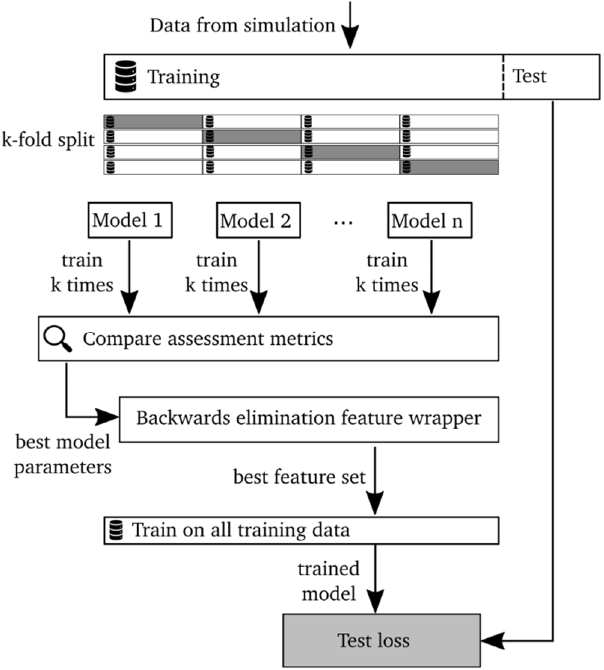
Figure 8. Workflow of the two-stage model selection process. At the first stage, the main neural network parameters are determined and at the second stage, the best set of features is determined through a backwards elimination feature wrapper method. Both stages use k-fold validation for the training and validation data set.